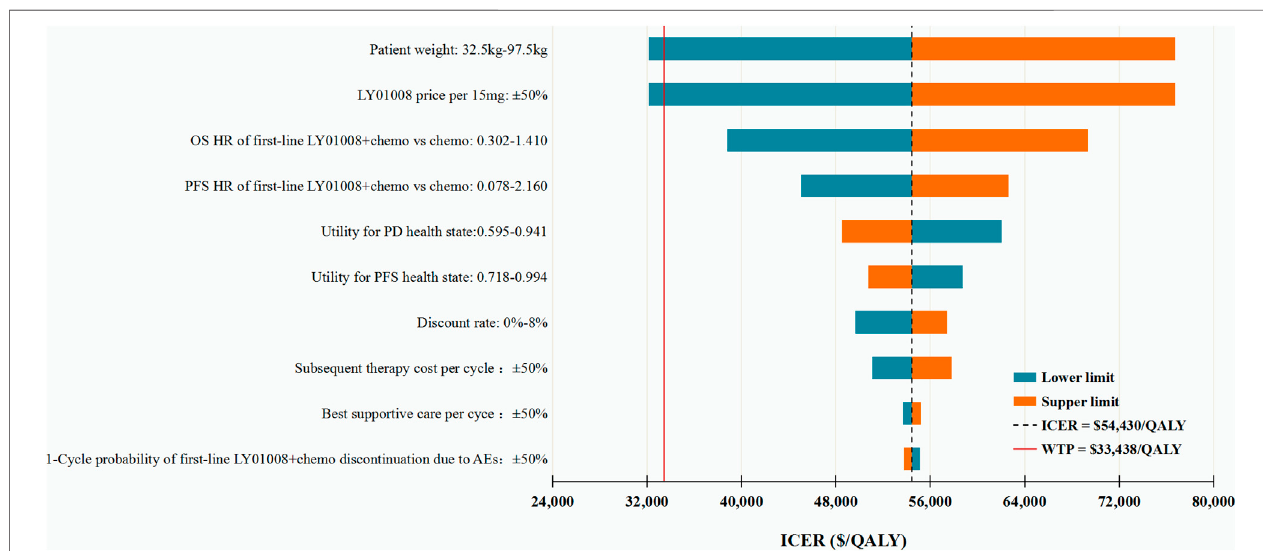
FIGURE 2 | Deterministic sensitivity analysis for the base case analysis. ICER, incremental cost-effectiveness ratio; QALYs, quality-adjusted life-years; OS, overall survival; PFS, progression-free survival; HR, hazard ratio; PD, progressive disease; BSC, best supportive care; AEs: adverse events.